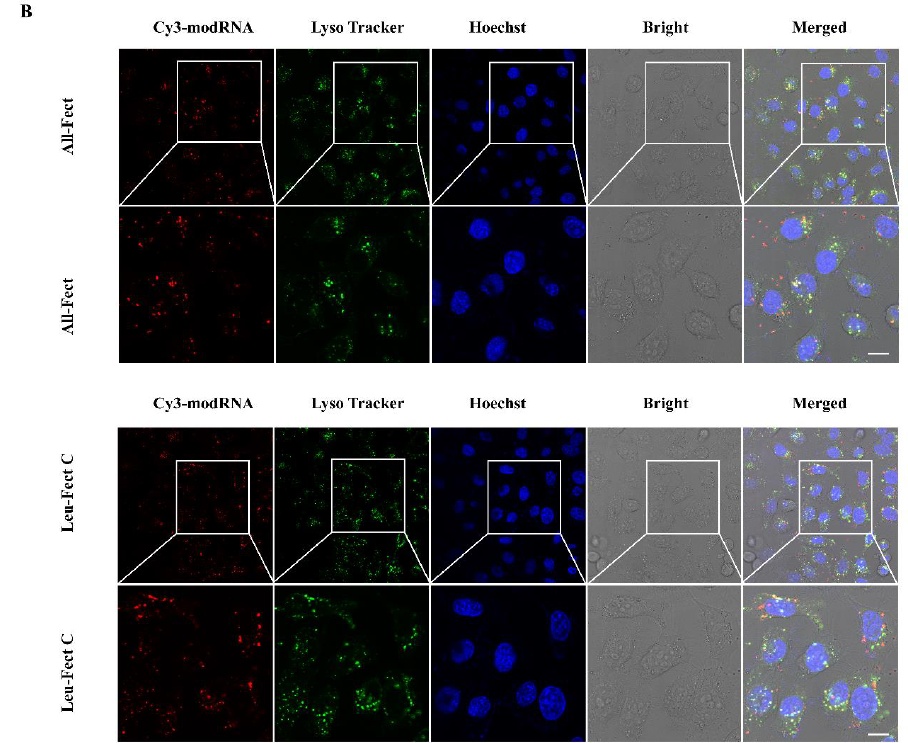
Figure 5. Cellular uptake route and intracellular localization of modRNA polymer complexes. ( A ) The GFP modRNA complex enters the cytoplasm over time, where it translates and expresses the target protein in 3T3 cells. The scale bar represents 200 μm. ( B ) Intracellular uptake images of Luciferase-modRNA polymer complexes in HeLa cells after 2 h, where cell nuclei were stained blue, lysosome was stained green, and modRNA was stained red. Scale bar is 25 µm.